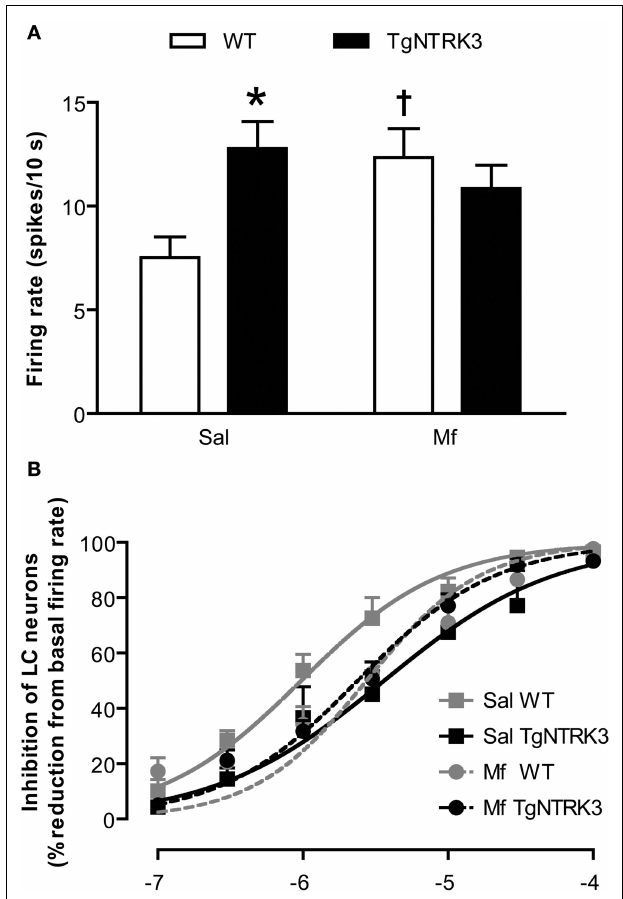
FIGURE 6 | Effect of morphine withdrawal on spontaneous fi ring rate of LC neurons and concentration-effect curves for met-enkephalin (ME)-induced inhibition. (A) To assess whether physical withdrawal signs of TgNTRK3 mice were paralleled at the cellular level by increased activities of LC neurons, we recorded the fi ring rates of these neurons in slices from WT (black bars) and TgNTRK3 animals (white bars) treated with saline or morphine. Single-unit extracellular recordings were performed 2 h after slices preparation to allow morphine to wash out. Bars represent the mean ± SEM. * p < 0.05 when compared with the corresponding WT group; † p < 0.05 when compared with the corresponding saline group (one-way ANOVA followed by a Tukey’s multiple comparison t test). (B) Concentration- effect curves were constructed for the inhibitory effect of the µ-opioid receptor agonist ME on the LC, by adding increasing concentrations of the drug (0.1–100 µM, 3.3 × ) at 5-min intervals until a maximal effect was reached. The horizontal axis represents the logarithmic value of ME concentrations. The vertical axis expresses the percentage of reduction in the fi ring rate from the basal rate. Data are mean ± SEM. at each ME concentration. The lines are the theoretical curves in each group constructed from the mean of the individual concentration-effect curve parameters, as estimated by nonlinear regressions (see Materials and Methods for details and Table 3 for mean values). In all groups, the maximal effect of ME was 100% of